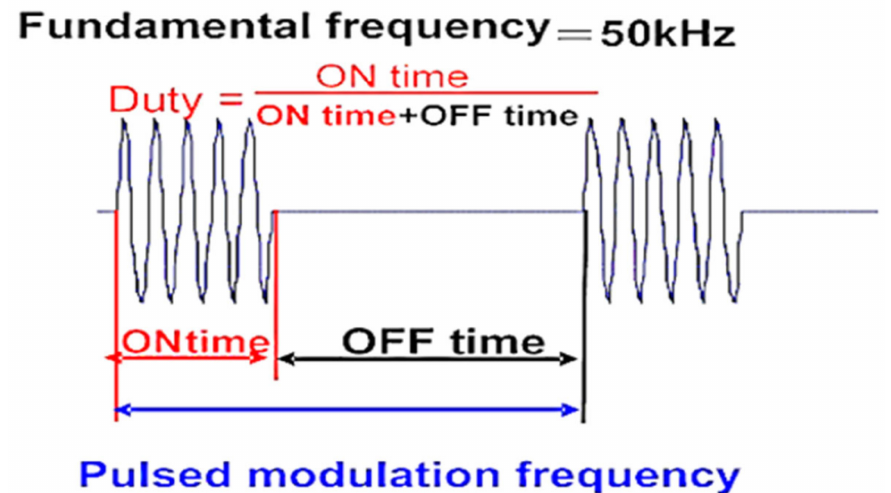
Figure 9. Pulse Modulation Control